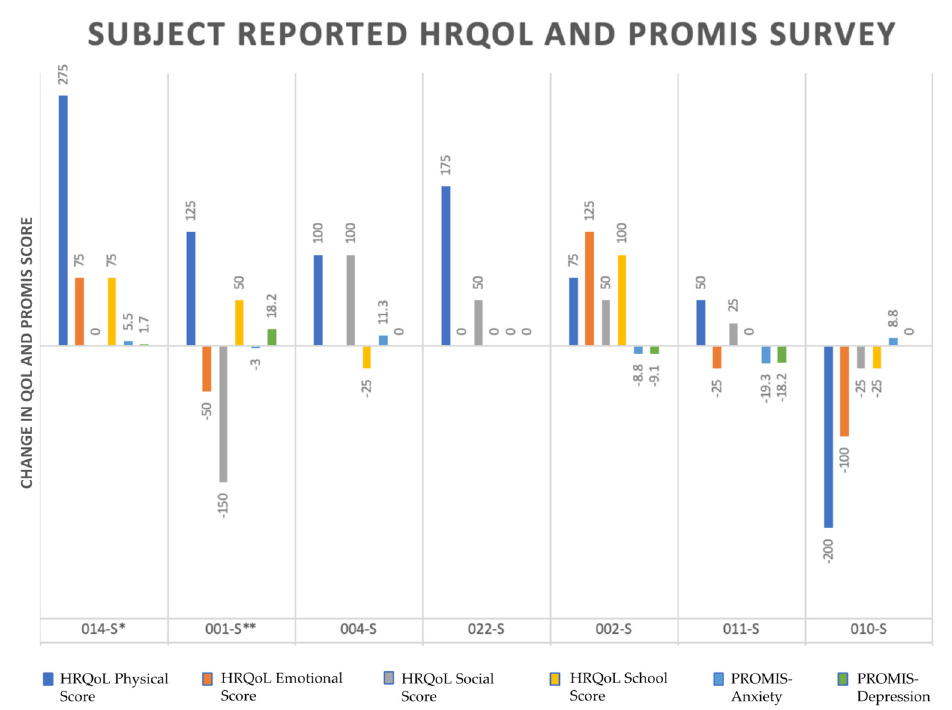
Figure 2. Change Over Time in Self-reported HRQoL and PROMIS scores. S − subject, * and ** subject corresponding to paired parent.